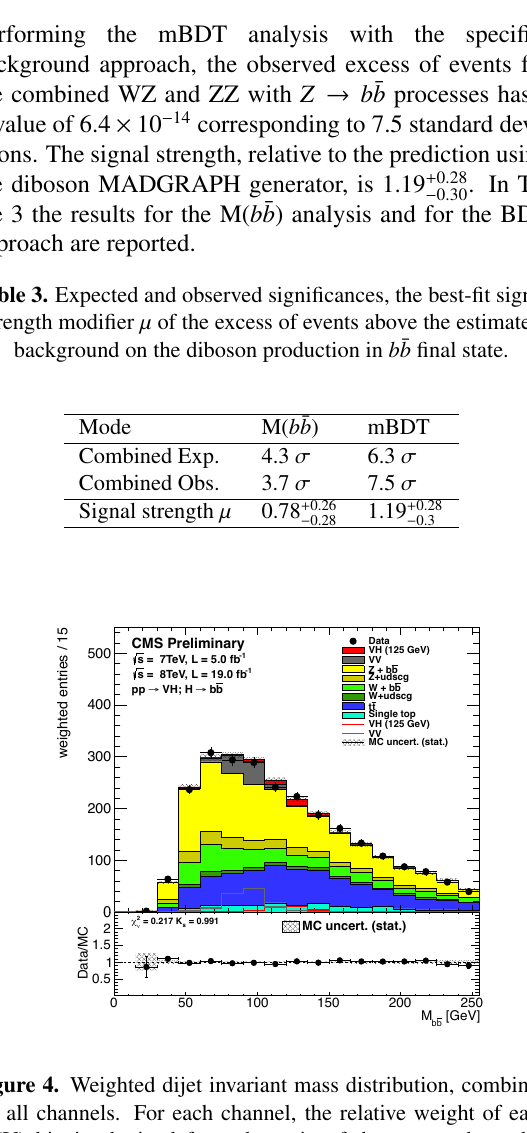
Variable p T (j): transverse momentum of each Z( b ¯ b ) daughter M (jj): dijet invariant mass